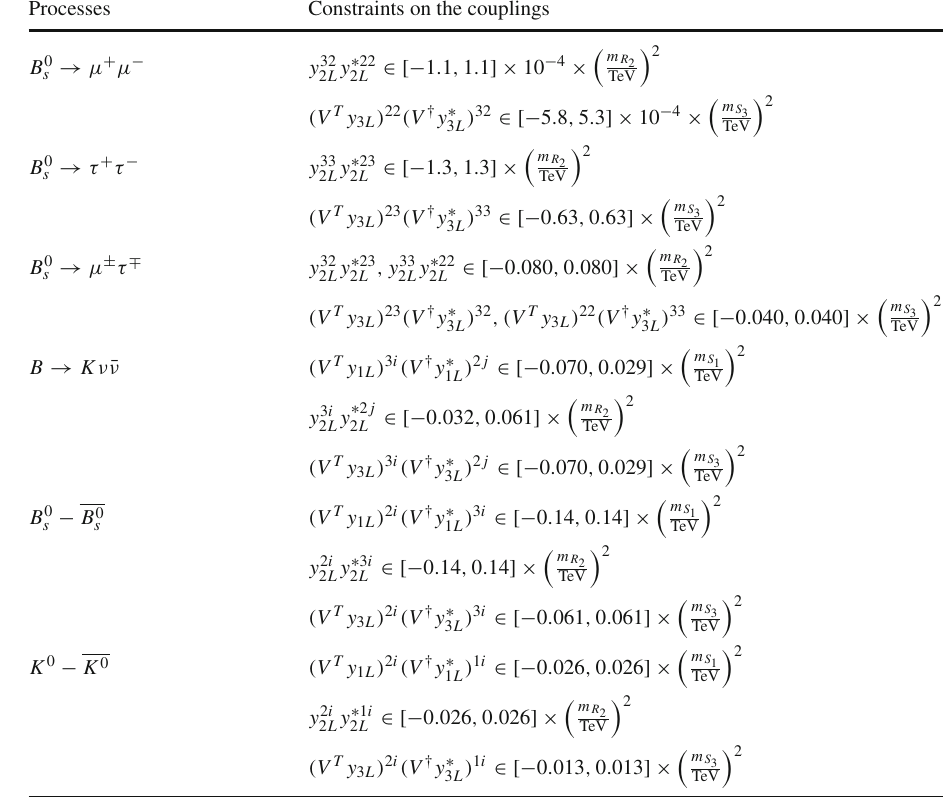
Table 3 Bounds on the leptoquark couplings from neutral mesons mixing and rare decay processes